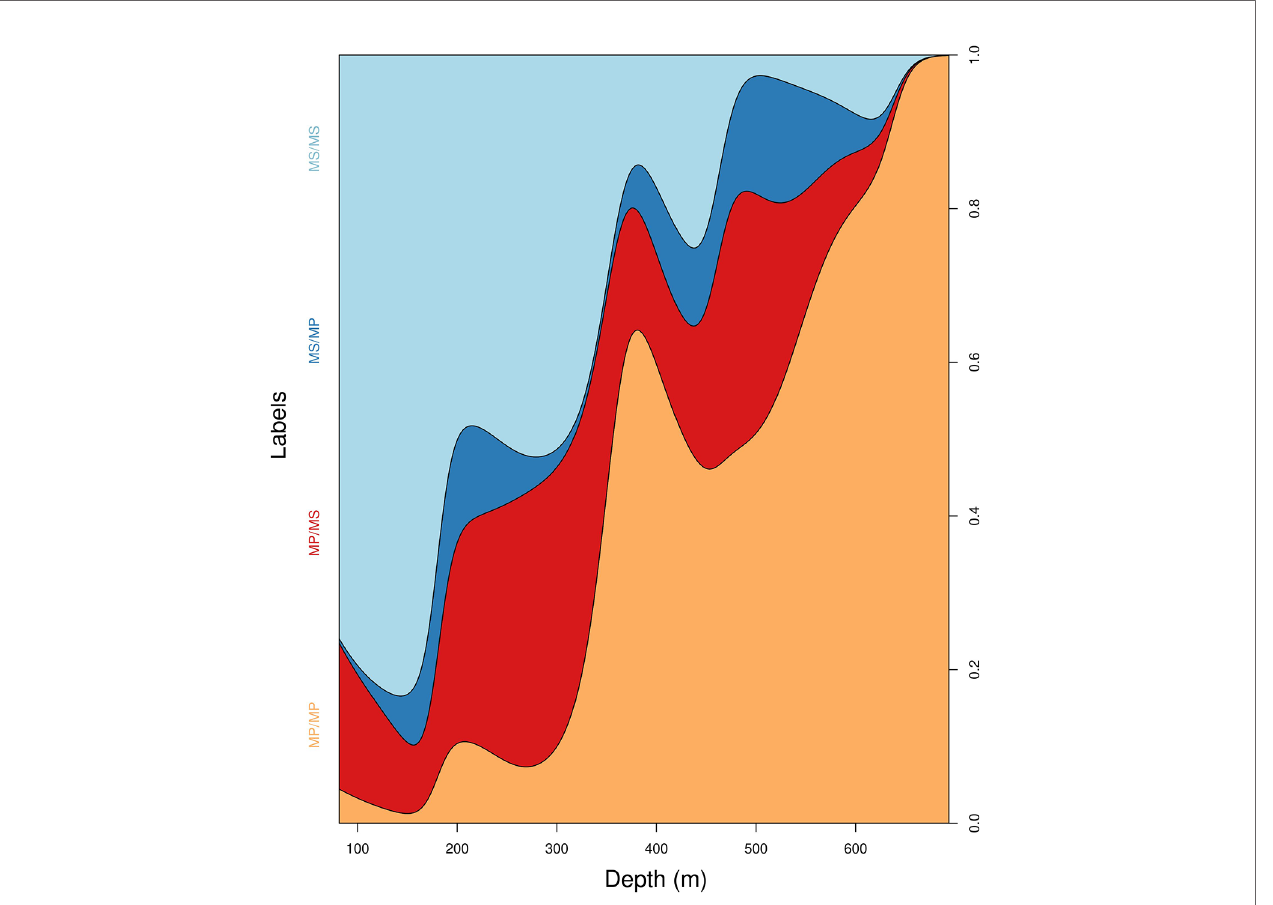
FIGURE 3 | Distribution of samples by labelling categories and depth. MP/MP: samples labelled as M . polli and DNA-assigned to M. polli (orange) ; MP/MS: samples labelled as M . polli and DNA-assigned to M. senegalensis (red) ; MS/MS: samples labelled as M . senegalensis and DNA-assigned to M. senegalensis (light blue) ; MS/ MP: samples labelled as M . senegalensis and DNA-assigned to M. polli